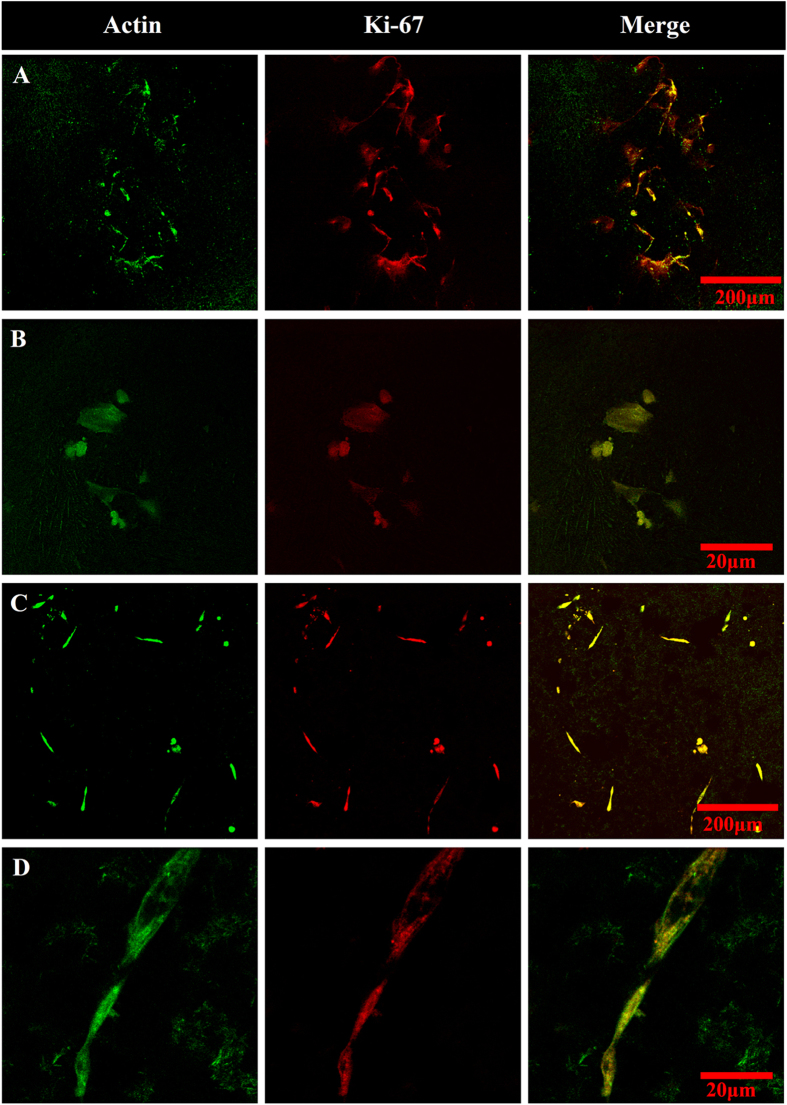
Representative confocal immunofluorescence microscopy of ADSCs for actin (λex = 488 nm, λem = 550 nm) and proliferation marker Ki-67 (λex = 543 nm, λem = 560 nm). Images taken for ADSCs grown for 5 days on glass coverslips at 10x (A) and 20x (B) magnification and MWCNT crosslinked substrates at 10x (C) and 20x magnification (D).